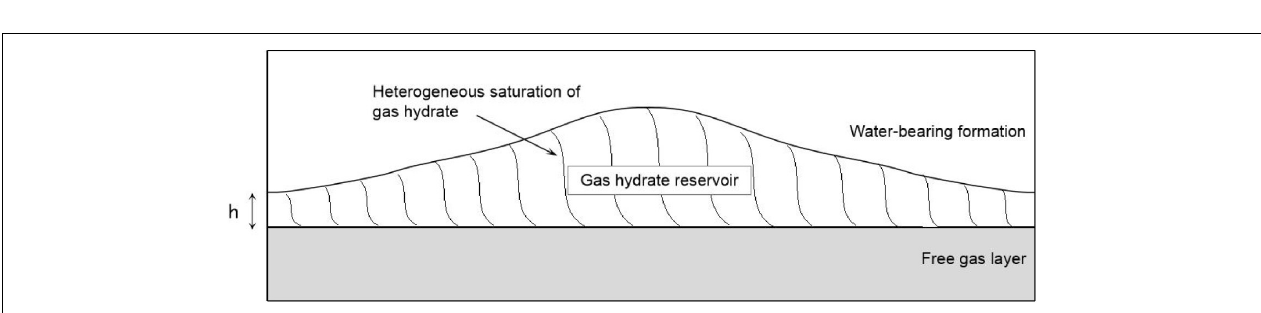
FIGURE 13 | A model of gas hydrate-bearing sediment that the gas hydrate saturation varies vertically and layer thickness varies laterally.